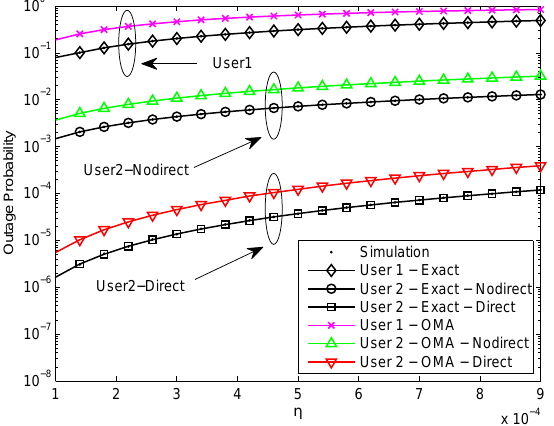
Figure 4. Outage probability versus relative channel estimation